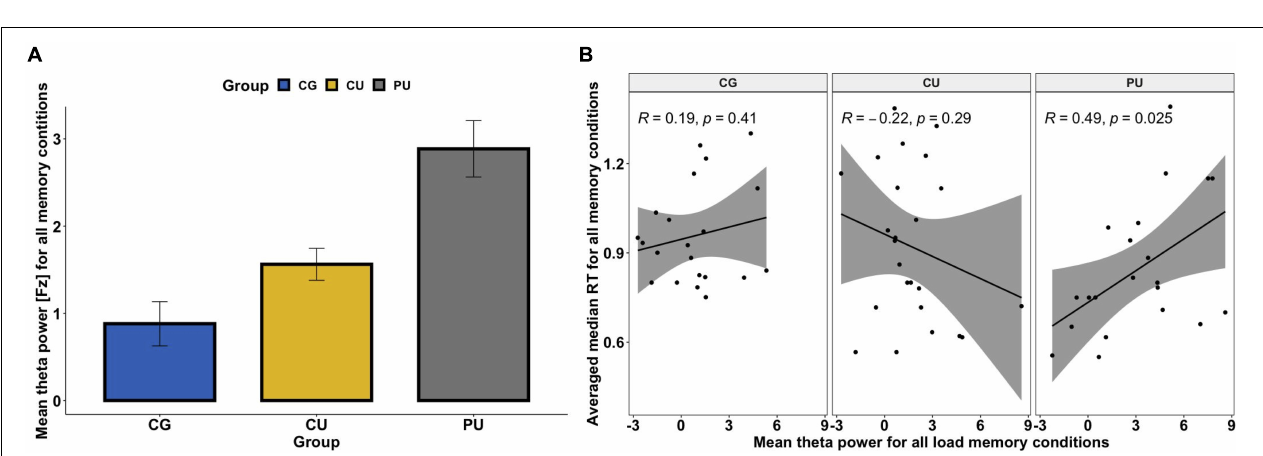
FIGURE 2 | Working memory performance—averaged median reaction times (SD) in ms for each memory load in Sternberg task for control group (CG), cannabis users (CU) and polydrug users (PU).